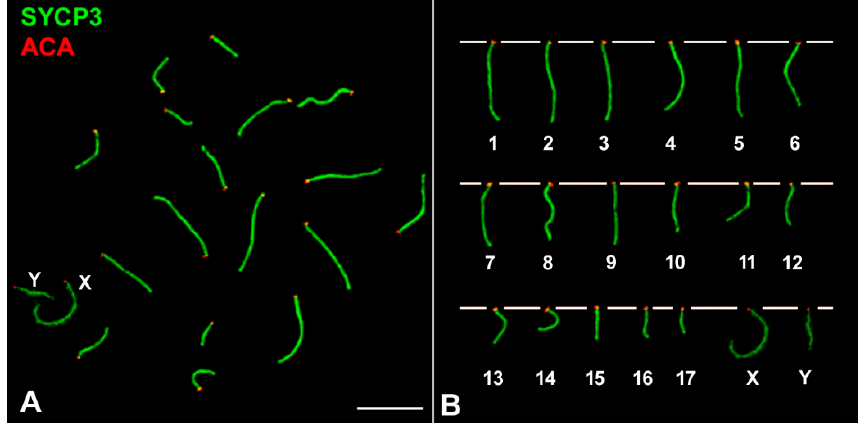
Figure 1. Chromosomes of Mus mattheyi ( A ) Spread spermatocyte at pachytene labelled with anti- bodies against SYCP3 (green) and centromeres (red). ( B ) Meiotic karyotype. Bivalents are arranged according to their length. The sex chromosomes (X, Y) are indicated. Scale bar: 10 µm.